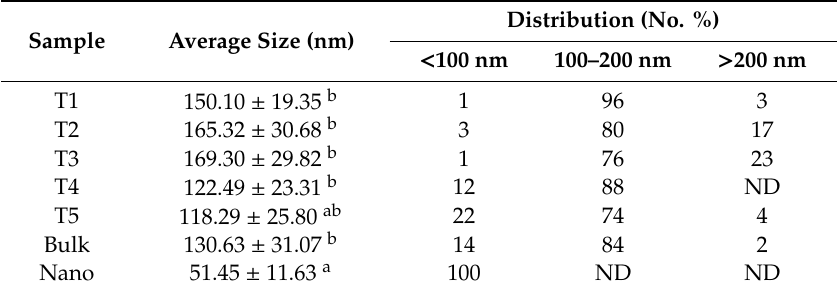
Table 1. Primary particle sizes and size distributions of food additive TiO 2 (T1–T5) and general-grade bulk and nano TiO 2 (bulk and nano) measured by SEM.